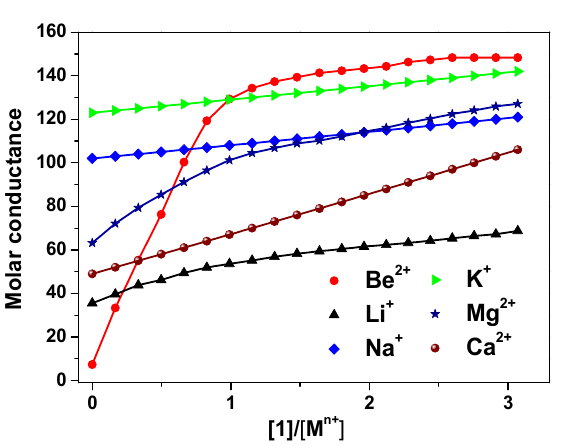
Figure 1. Chemical structure of 1 .